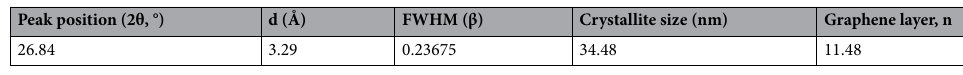
Table 1. XRD analysis detail of carbon peak (002) of GSC WCO